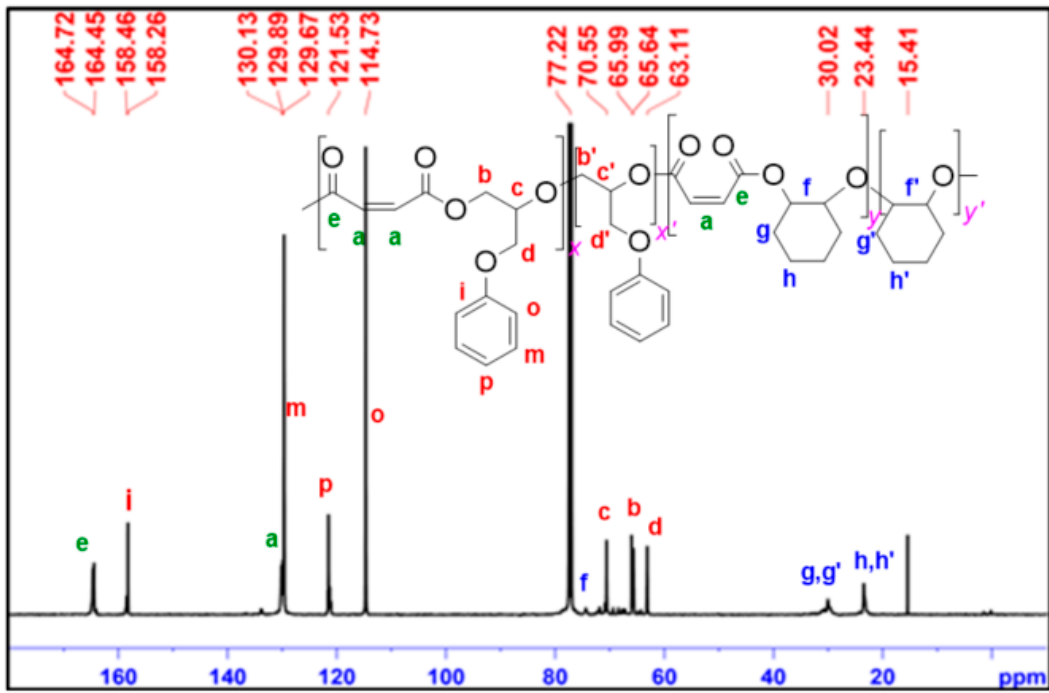
Figure 2. 13 C NMR spectrum of terpolymer poly(CHO-PGE-MA) (Table 4, entry